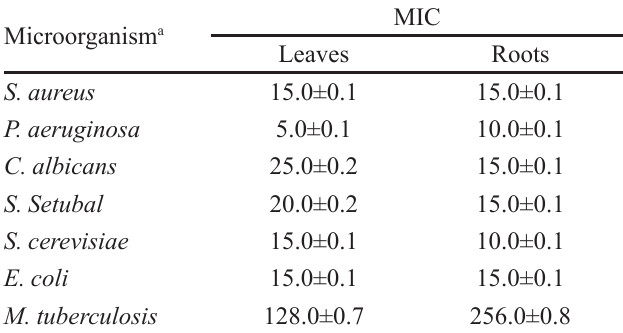
Data are mean values of three replicates in µg mL -1 ± standard desviation. MIC, minimal inhibitory concentration. a Obtained from the American Type Culture